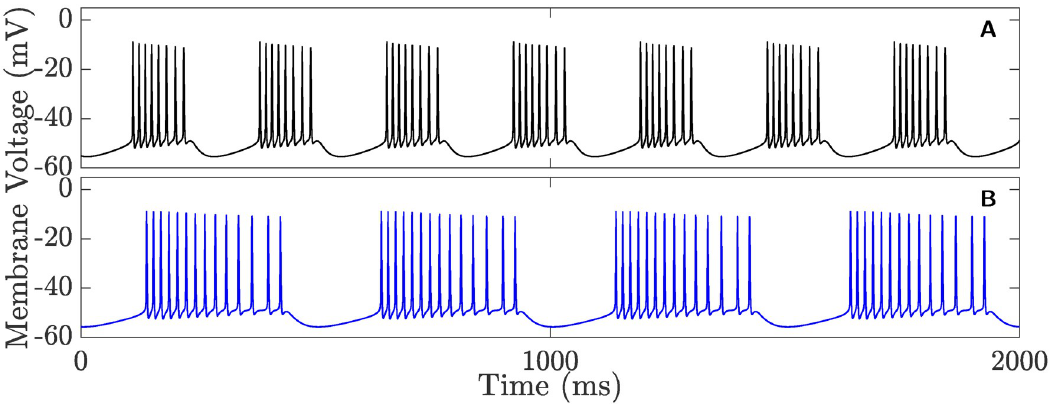
Fig 4. Two time courses of the membrane voltage ( V ) produced by the full system (1) during post-runup. Both exhibit bursting when A ) ( g HVA , g A ) = (0.26, 6.0) μ S.cm − 2 , and B) ( g HVA , g A ) = (0.235, 12.2) μ S.cm − 2